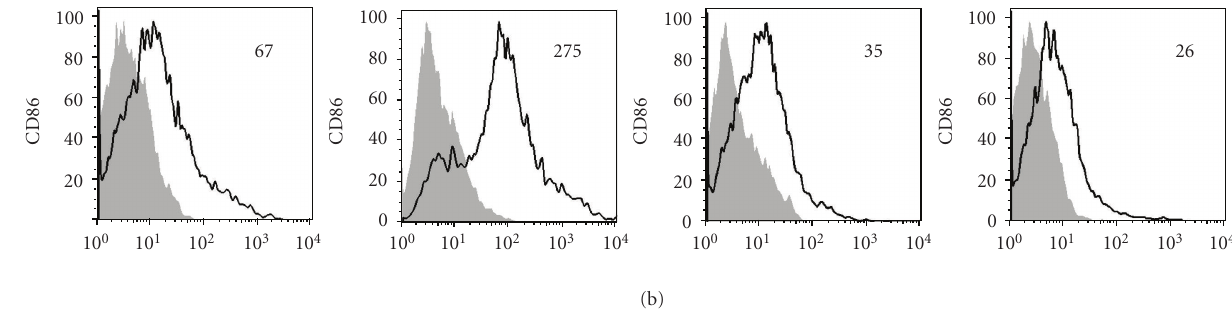
Figure 3: DCs were transduced with nothing (No treated), CD80 lenti , CD86 lenti , NC lenti , or both CD80 lenti and CD86 lenti . (a) After 6 days of culture, the cells were then incubated with LPS (1 μ g/mL) for 18 hours. Expression of CD80 and CD86 was determined by flow cytometry. The data show the e ff ect of recombinant lentivirus on inhibition of target molecule expression. Values expressed as mean ± 1SD from three independent experiments; ∗ P < . 05 compared to NC lenti /No treated; ∗∗ P < . 05 compared to CD80 lenti ; ∗∗∗ P < . 05 compared to CD86 lenti . (b) C3H BM-derived DCs were cultured over 6 days. DCs were stimulated or unstimulated with LPS (1 μ g/mL) for 18 hours. Upregulation of CD80 and CD86 in response to LPS was also suppressed by CD80 lenti and CD86 lenti . The mean fluorescence intensity (MFI) of GFP+ cells expressing the marker of interest is indicated.